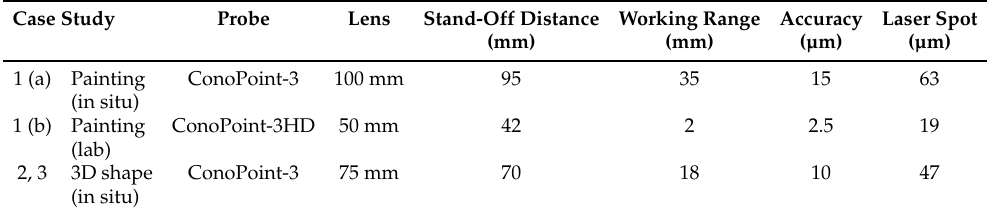
Table 1. Summary table of the sensor parameters for each case study.